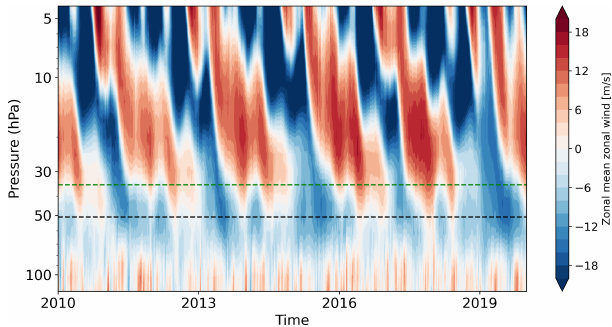
Figure 1. The equatorial (5 ◦ S–5 ◦ N) zonal-mean zonal winds from 2010–2020 based on the present-day climate of the GLENS simu-